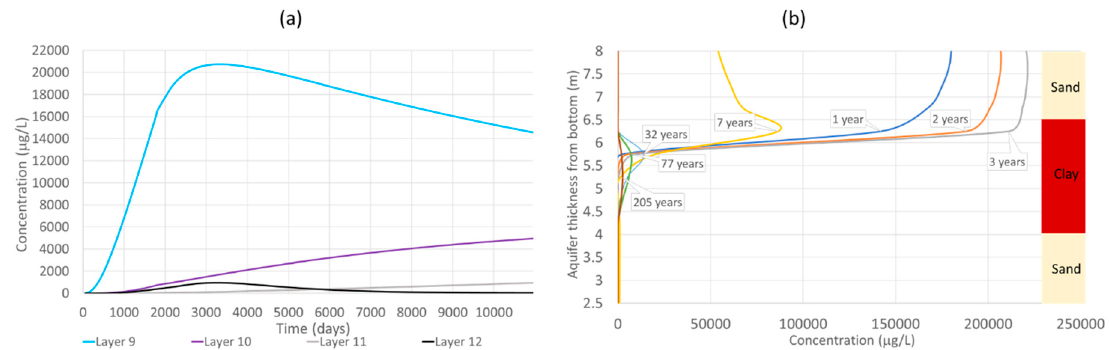
Figure 10. Concentration distributions over time in the nontransmissive zone, in different layers ( a ). Concentration distributions along the vertical axis in OBS1, at different times ( b ).